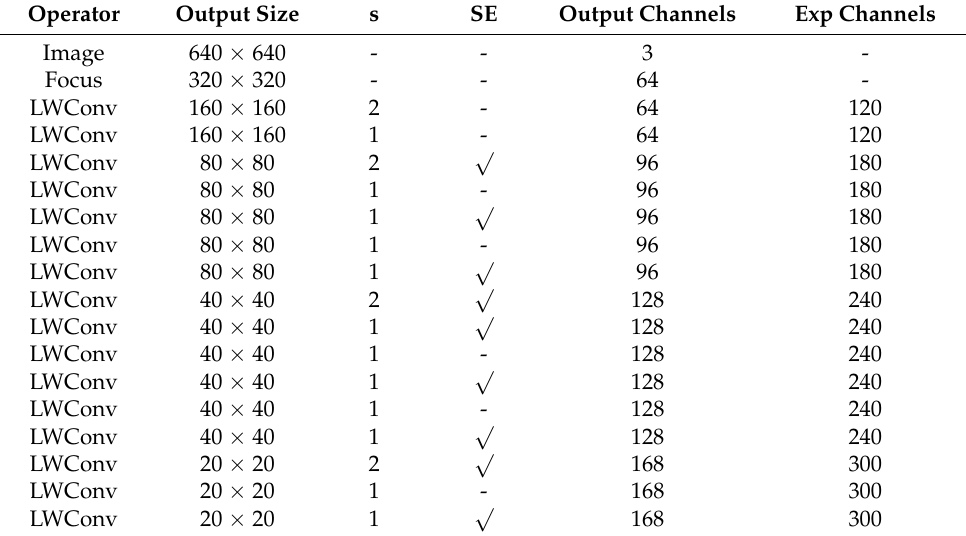
Table 4. Specification for the